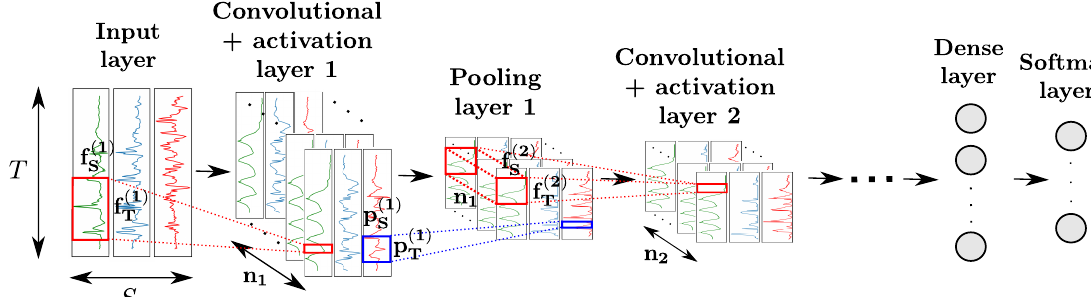
Figure 4. Architecture of a CNN model for sensor-based HAR. T , S and n k designate the time length of the input data, the number of sensor channels, and the number of convolutional kernels of the k th layer, respectively. The convolutional and pooling kernels of the k th layer process patches of the input ( k ) ( k ) ( k ) ) and ( p ( k ) ) , respectively. Neurons of intermediate convolutional layers data of sizes ( f , f , p T T S S perform convolution products across all convolutional maps of the previous